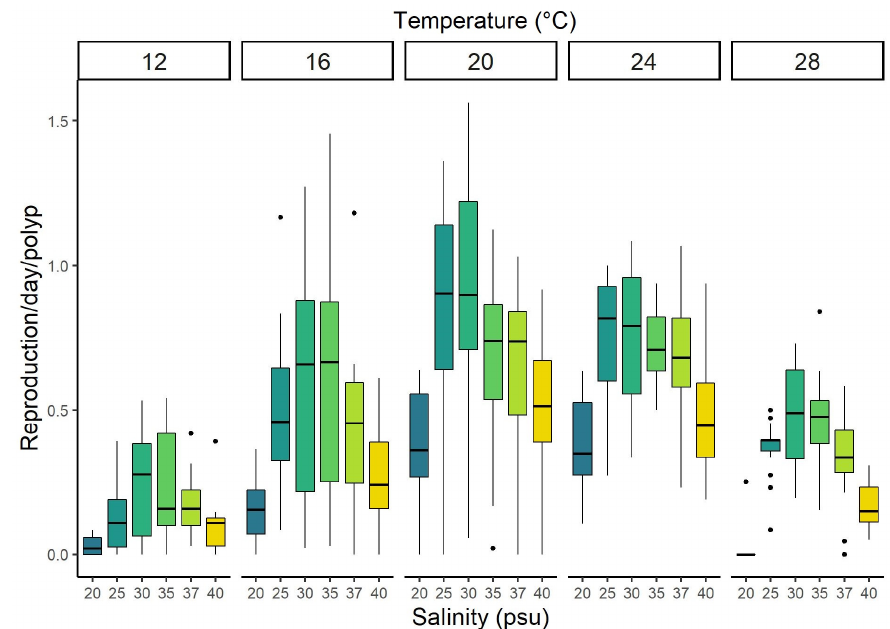
Figure 3. Asexual reproduction output (budding and podocysts combined) of Aurelia solida polyps kept at 30 different combinations of temperatures and salinities over 56 days of the experiment ( n = 12 per combination). Values are standard- ized by the number of polyps and days and presented as boxplots including quartiles (box and whiskers), median (hori- zontal line), and outliers (points).